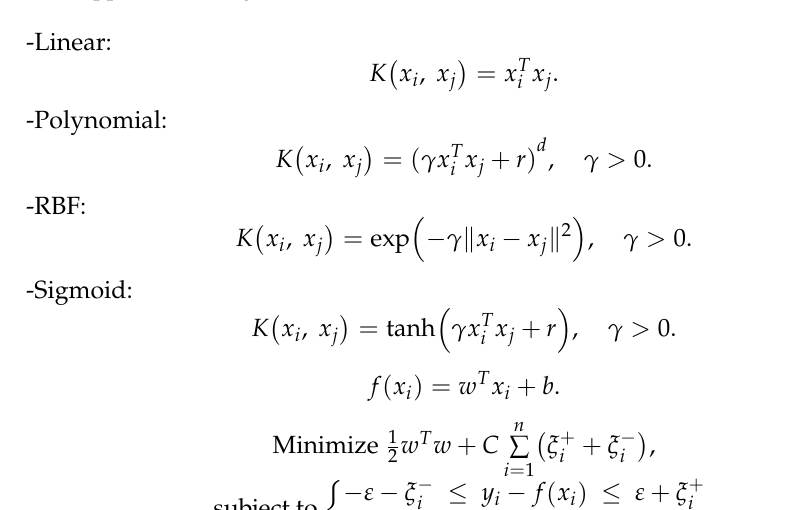
Figure 7. Support vector